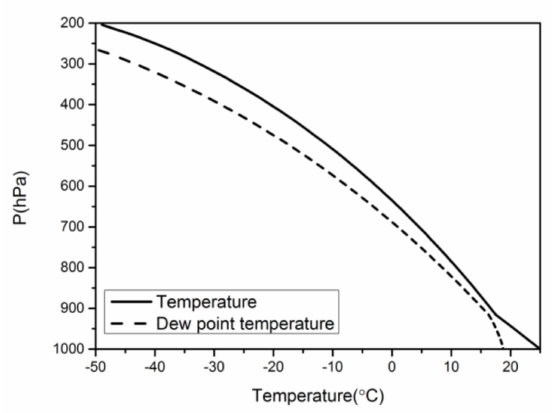
Figure 1. Temperature and dew point temperature profiles of the initial